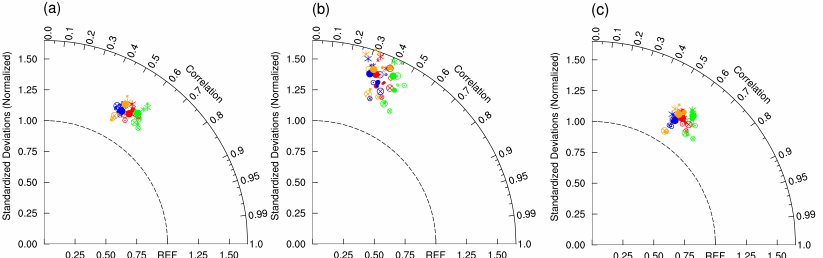
Figure 9. Taylor diagrams show the four-case averaged normalized standard derivation and correla- tion for 48 ensemble members during 12:00–23:00 UTC ( a ), 00:00–11:00 UTC ( b ) and 24 h ( c ). Shapes represent the MP schemes: Lin ( ∗ ), WSM6 ( (cid:12) ), Goddard ( ⊗ ), Thompson ( • ); colors represent the PBL schemes: YSU (red), MYJ (blue), QNSE (orange), ACM2 (green); sizes represent the CU schemes: KF (small), BMJ (moderate), GD